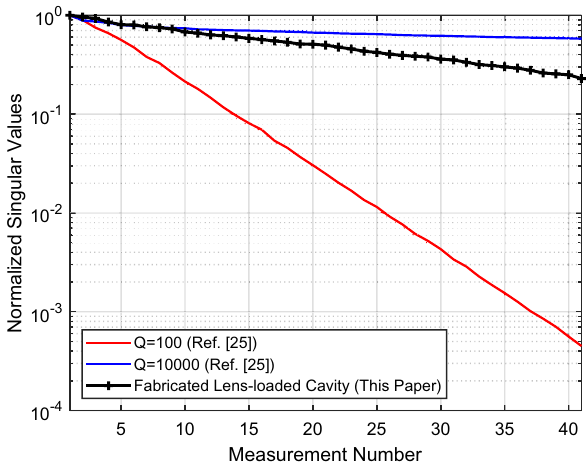
Figure 11. SVD contours for the physical lens-loaded